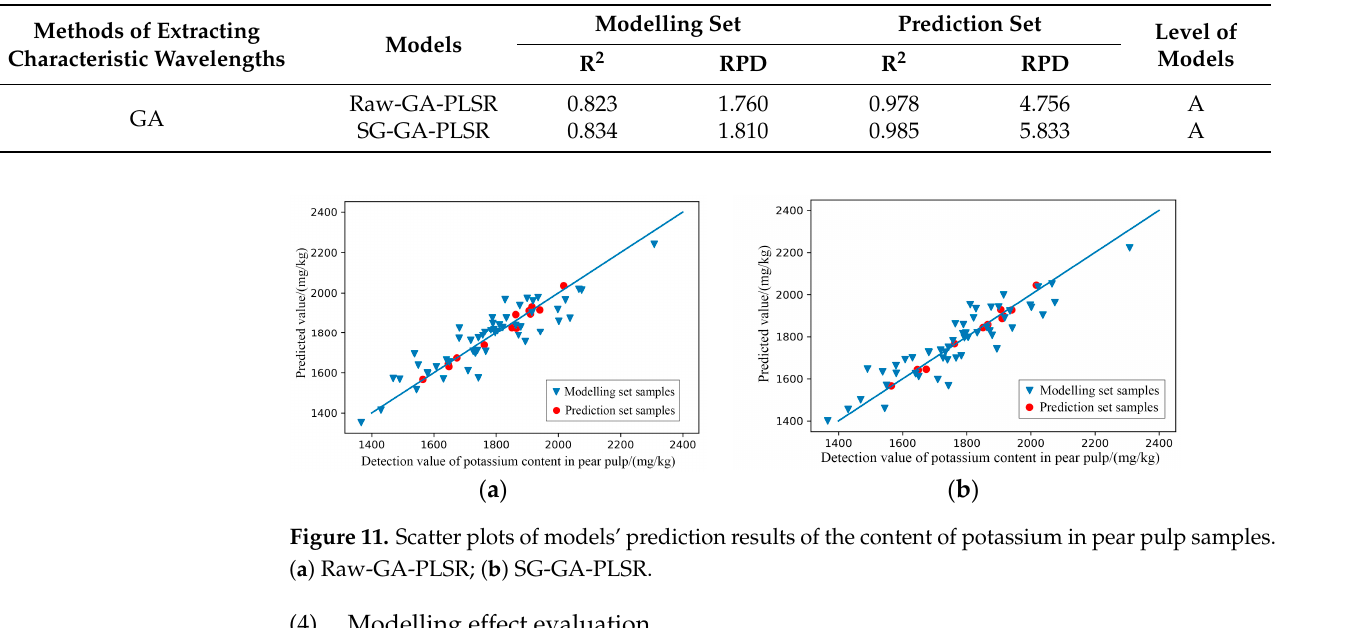
Table 5. Modelling prediction results of the content of potassium in pear pulp based on the selected characteristic wavelengths.